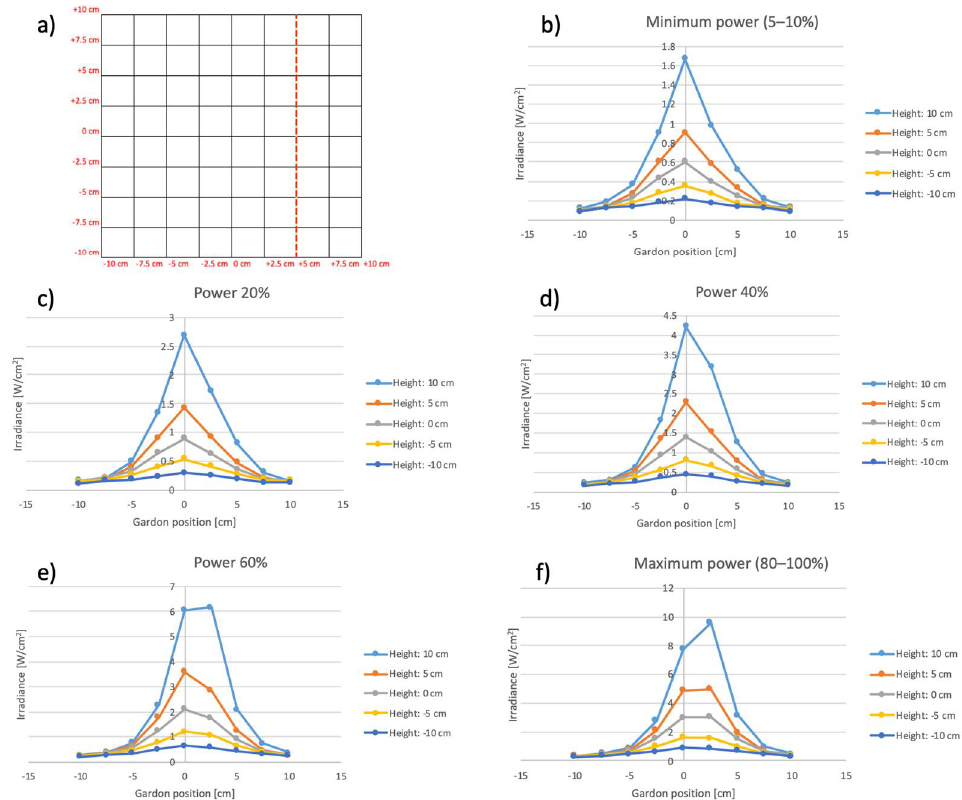
Figure 15. Irradiance along the horizontal line (+5 cm) highlighted in ( a ), for several heights of the workbench; all graphs are related to the lamp #7; ( b ) electrical power of lamp 5–10%; ( c ) electrical power of lamp 20%; ( d ) electrical power of lamp 40%; ( e ) electrical power of lamp 60%; ( f ) electrical power of lamp 80–100%.